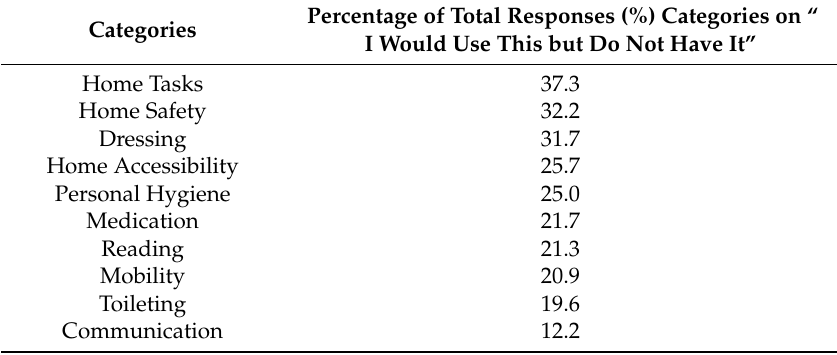
Table 3. Most frequently identified categories of assistive technology devices identified as “I would use this but do not have